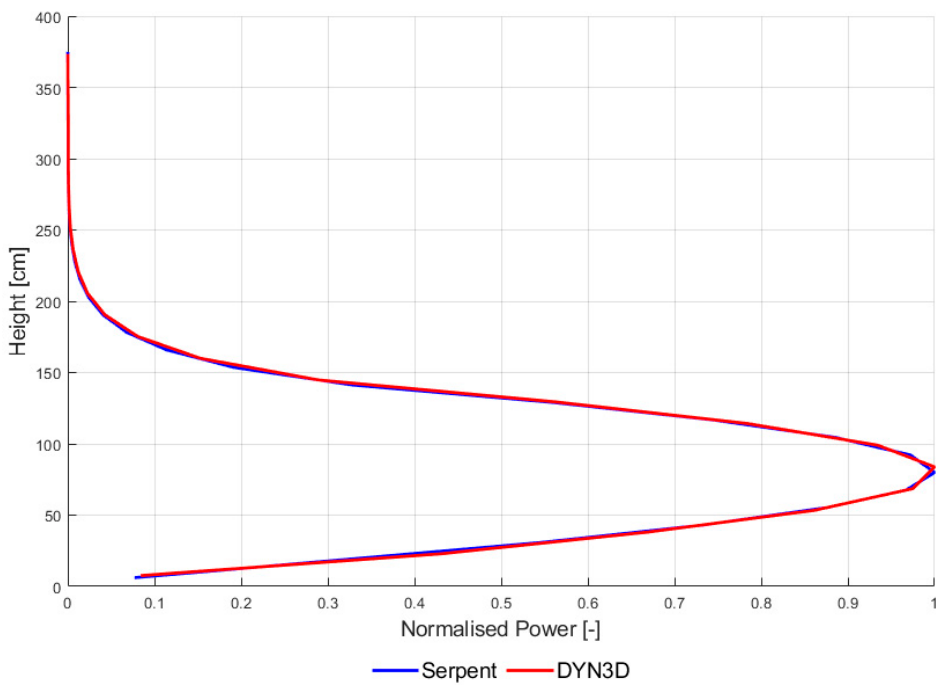
Figure 10. Assembly two’s four-level design with a uniform water density across the axial height of the assembly.